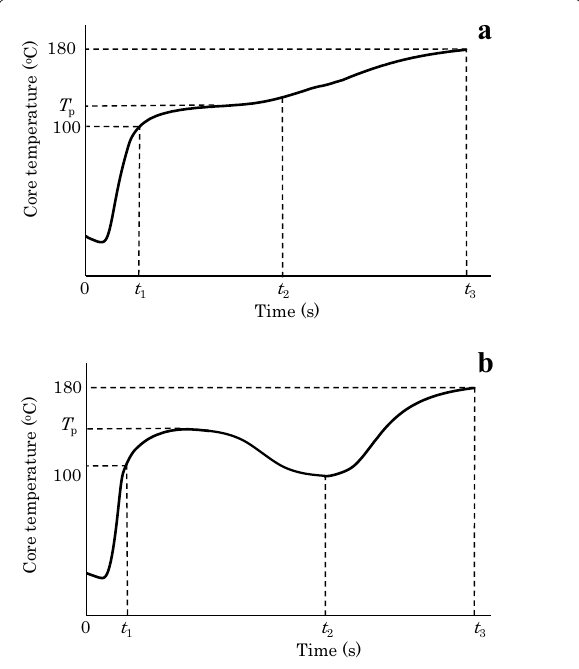
Fig. 4 Representative temperature–time curves in the mat core with indices: t these curves were VP max and the rate of vapor pressure increase VP rate . Here, VP rate defines the rate of vapor generation and vapor flow, and is calculated as: